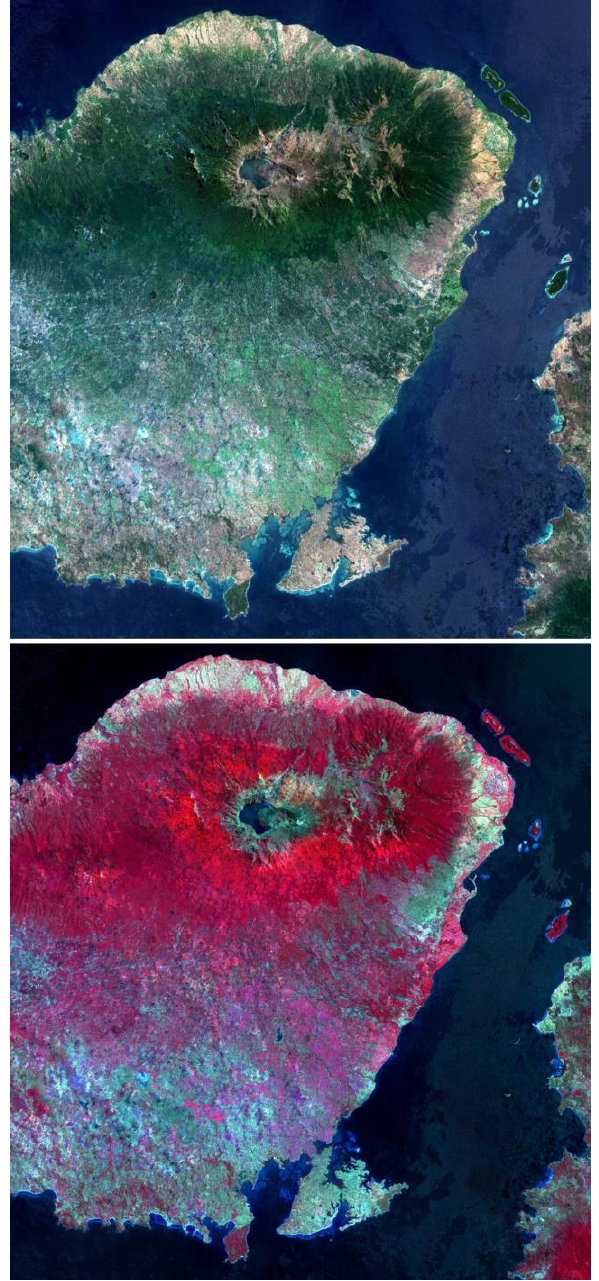
Figure 8. Post-disaster cloudless image: natural color (at the top), and infrared color combination (at the bottom)